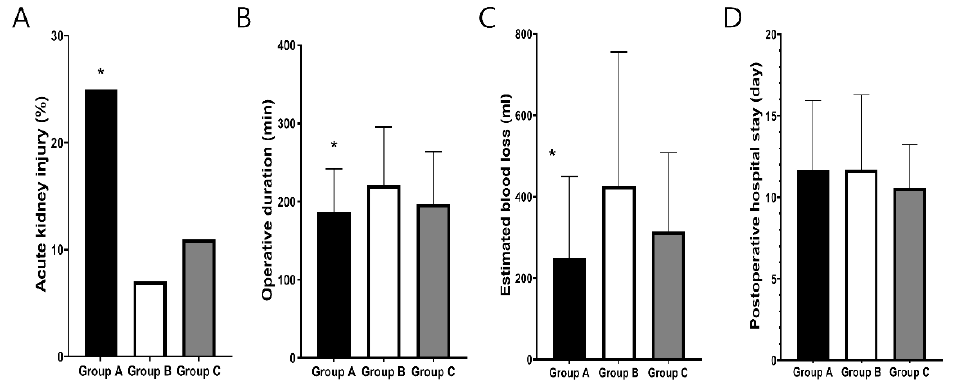
Figure 2. Differences in intraoperative and postoperative outcomes including estimated blood loss ( A ), operative duration ( B ), postoperative hospital stay ( C ), and incidence of postoperative complication ( D ) according to BMI and CVP. * p < 0.05 BMI, body mass index; EBL; CVP, central venous pressure.